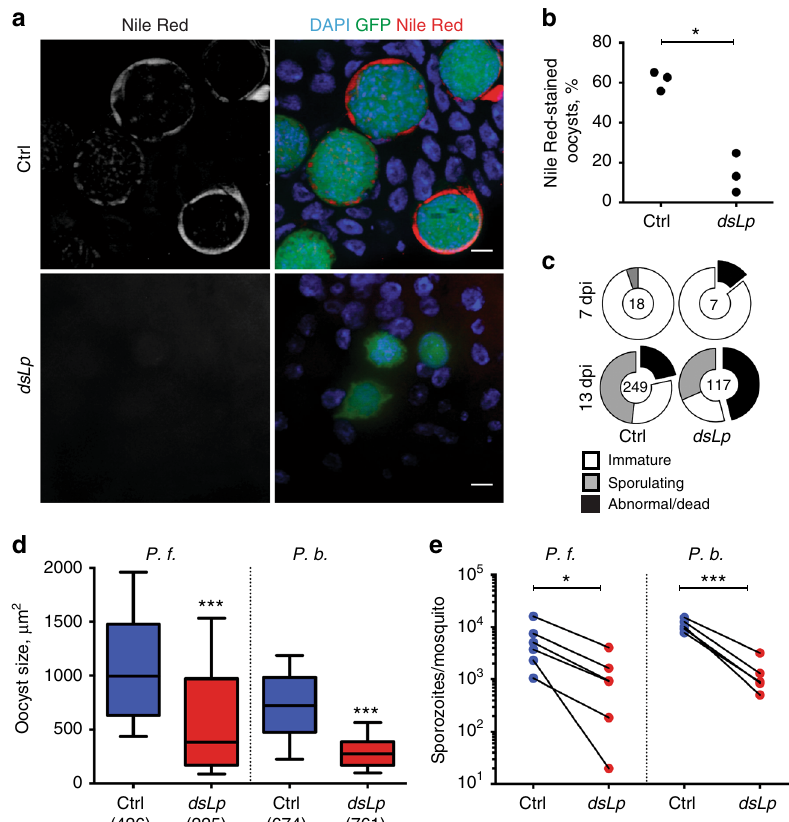
Fig. 3 Mosquito lipids regulate within-vector parasite sporogony. Control and Lp-de fi cient female mosquitoes were infected with P . berghei ( P.b .) ( a – c ) or P. falciparum ( P.f.) ( d , e ) parasites. a Neutral lipids detected by the Nile Red stain in the GFP-expressing P. berghei oocysts (green) 13 day post infection (dpi)